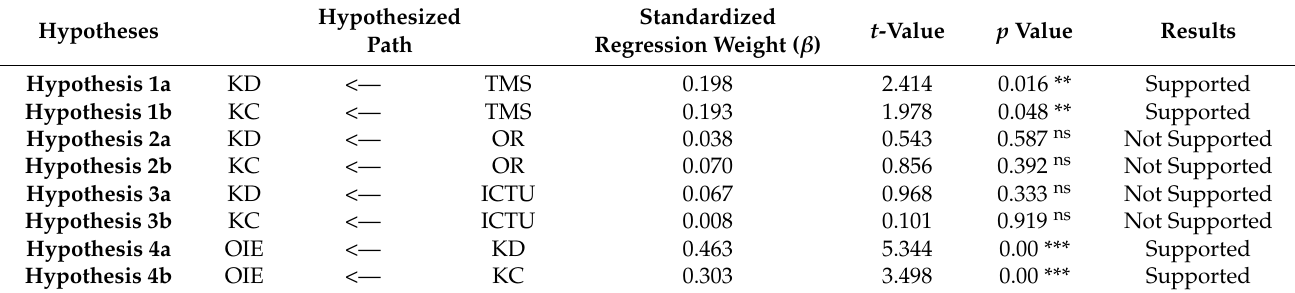
Table 4. Results of the structural model.